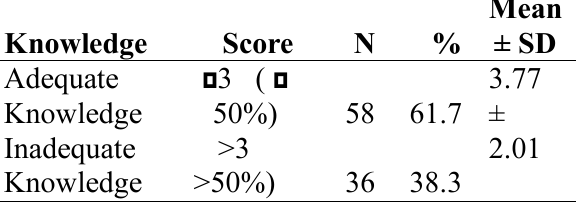
Table 7: Overall Knowledge Score: